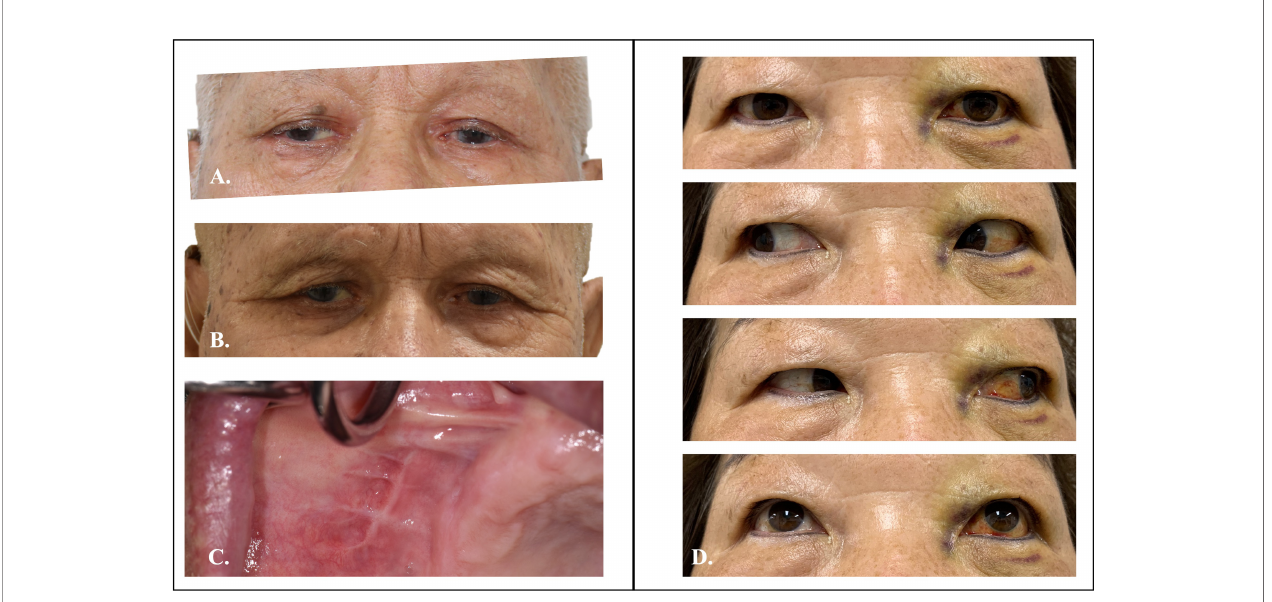
FIGURE 11 | Preoperative and postoperative clinical photo of Case 1 and 2. (A) Preoperative photo of case 1 showed mild proptosis over right-side eye. (B) Symmetry of eye position after TMEA excision of orbital tumor. (C) Postoperative oral wound healed well. (D) Two weeks postoperative photo of case 2 showed well functional orbital